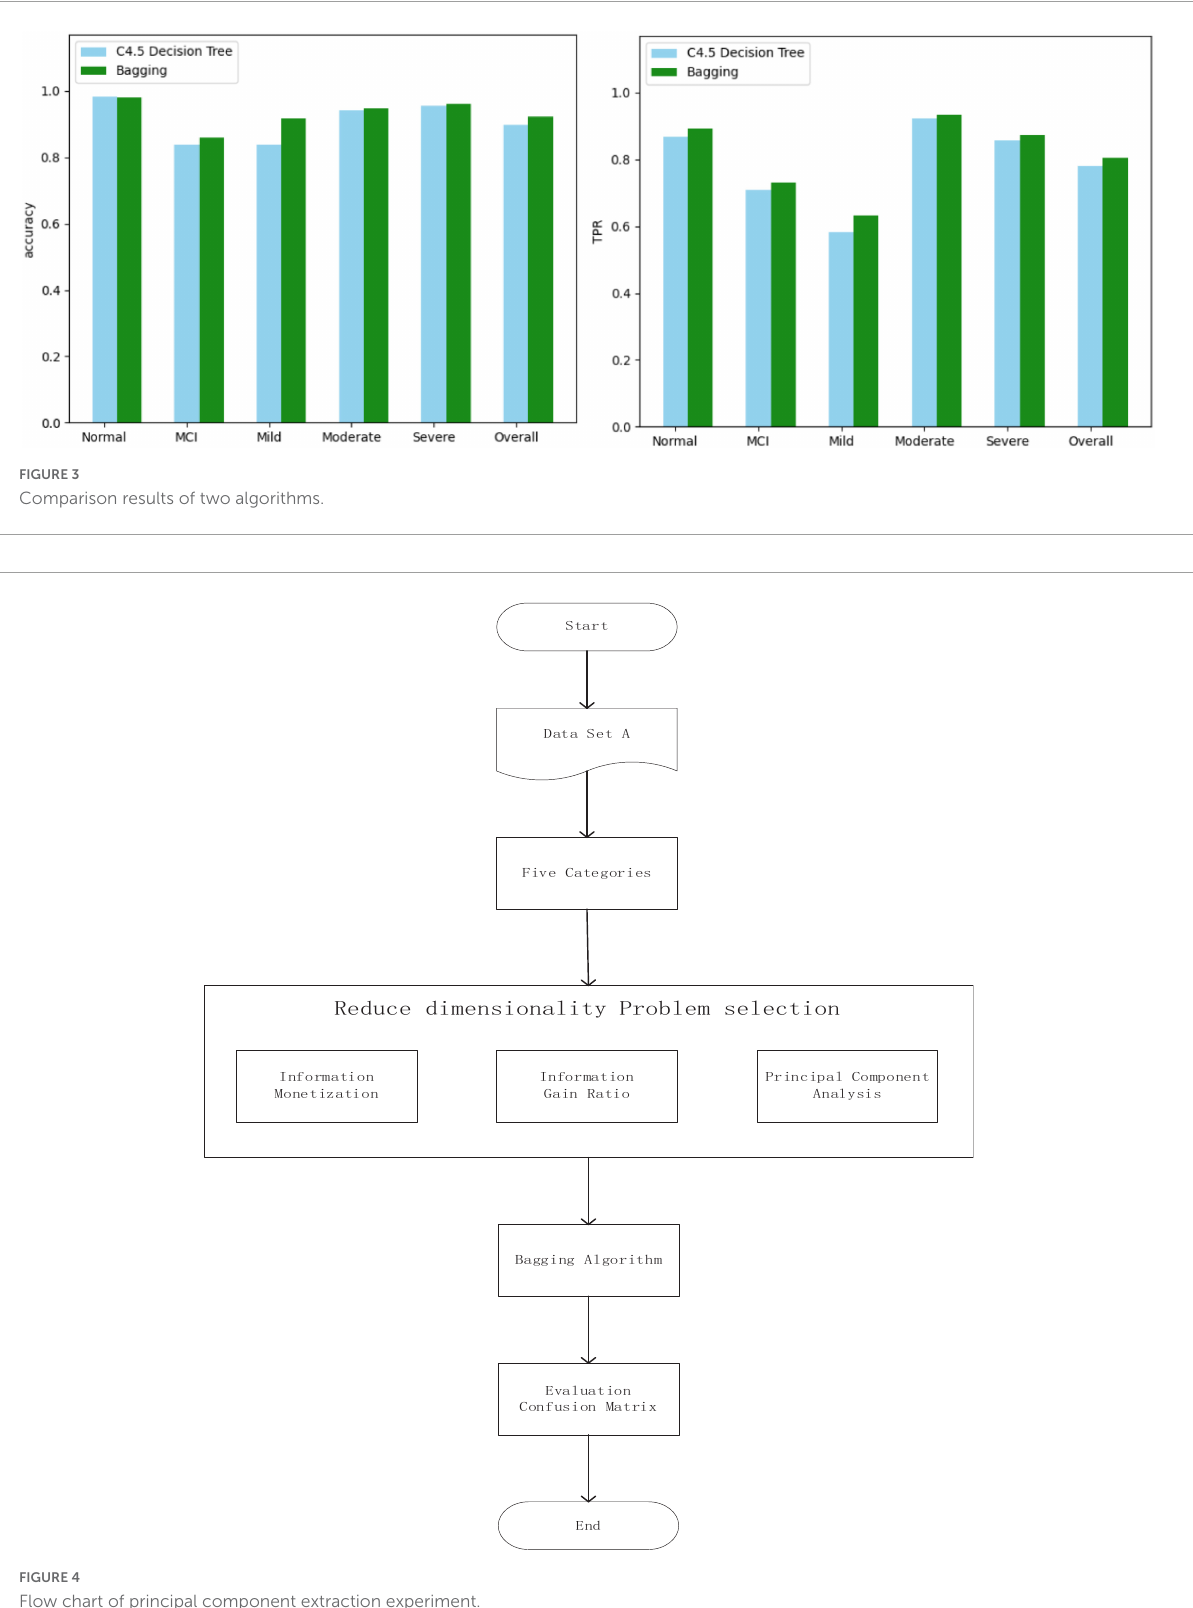
FIGURE4 Flow chart of principal component extraction